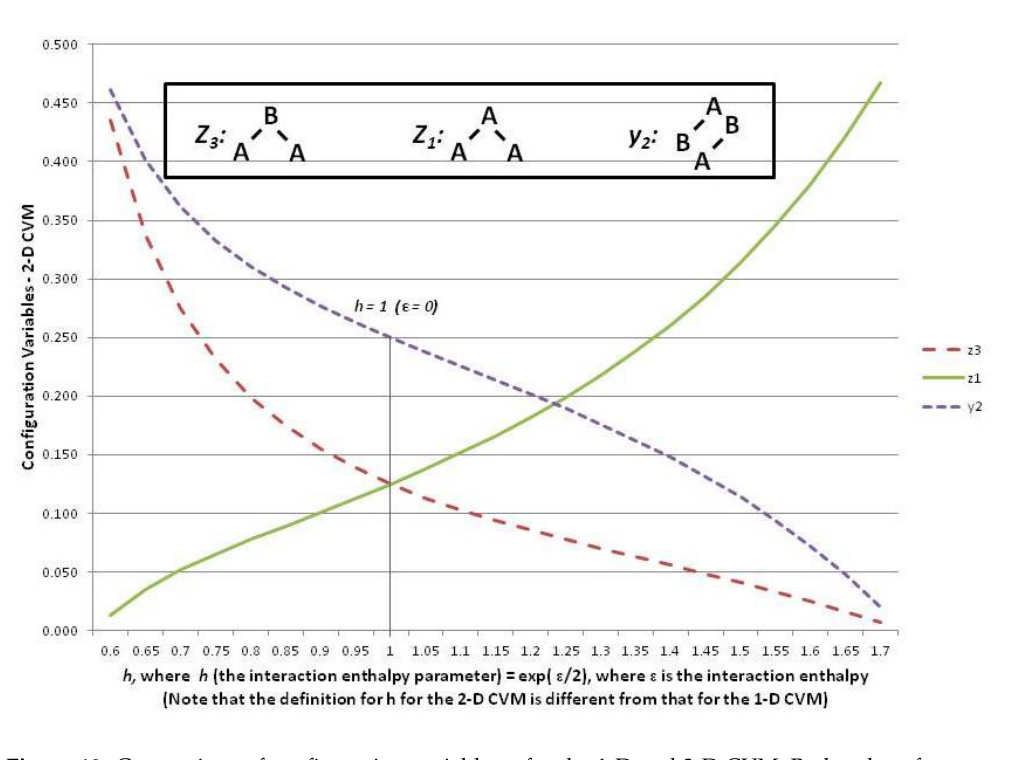
Figure 10. Comparison of configuration variable z 3 for the 1-D and 2-D CVM. Both values for z 3 are the expected 0.125 when h =